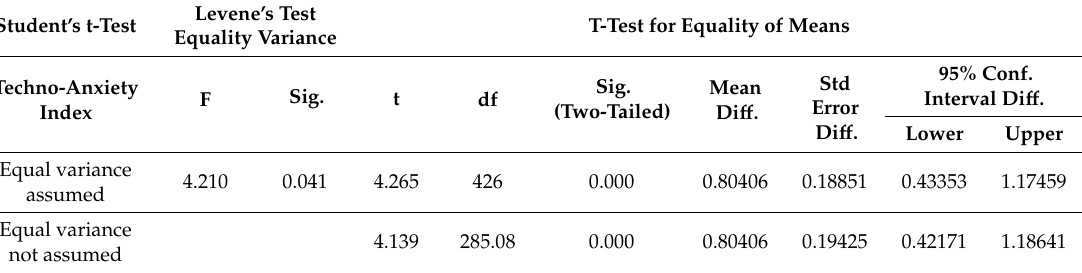
Table 3. Techno-anxiety Student’s